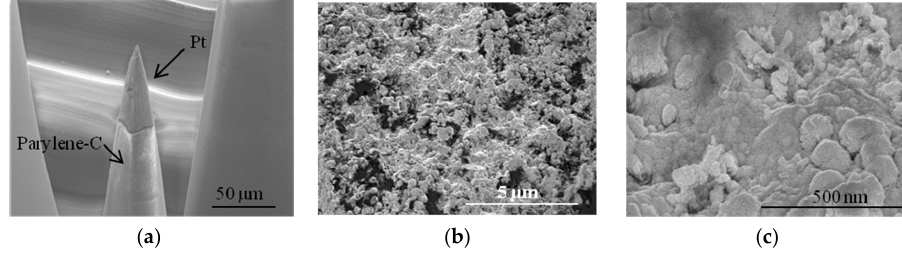
Figure 8. SEM images of microelectrodes after tip-metallization with Pt ( a – c ) at different magnification. Pt has granular